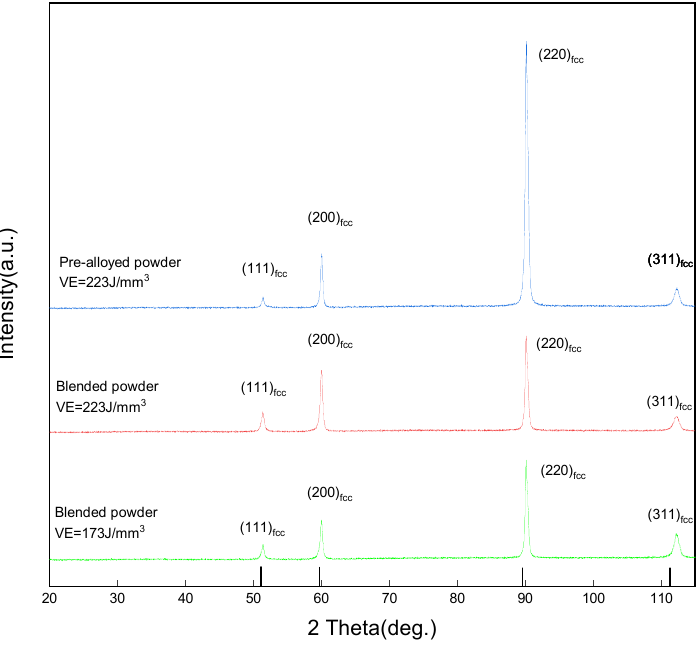
Figure 9. XRD (X-ray diffraction) patterns of as-printed samples.